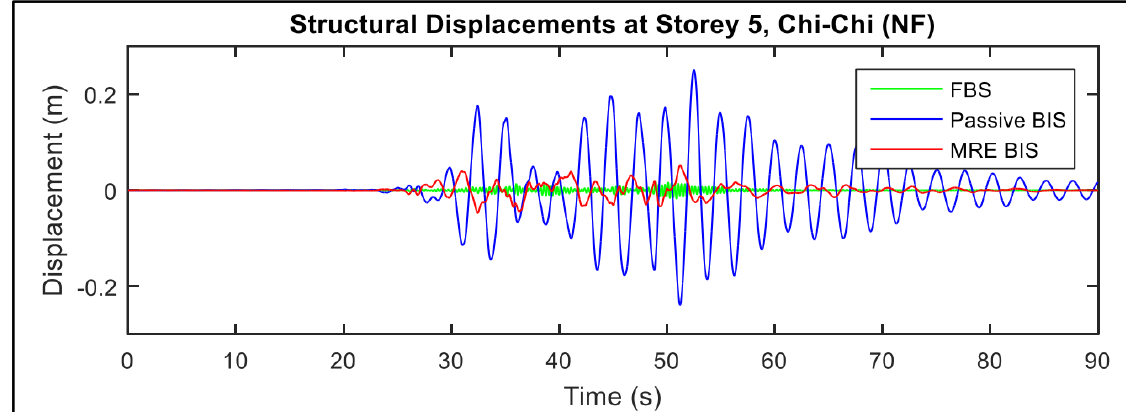
Figure 6. Displacement time history at storey 5 for the Chi-Chi earthquake.